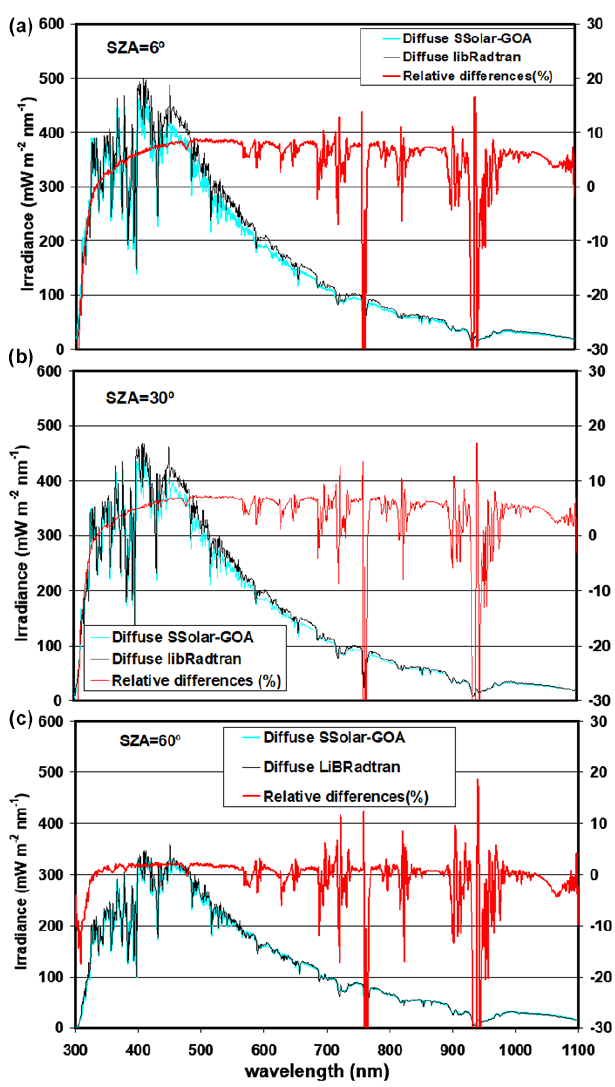
Figure 6. Comparison between libRadtran and SSolar-GOA models for diffuse irradiance at SZA = 6, 30, and 60 ◦ , respectively (from top to bottom), with input parameters shown at the top of Fig. 3. Right y axis indicates the relative differences in percentage (libRad- tran minus